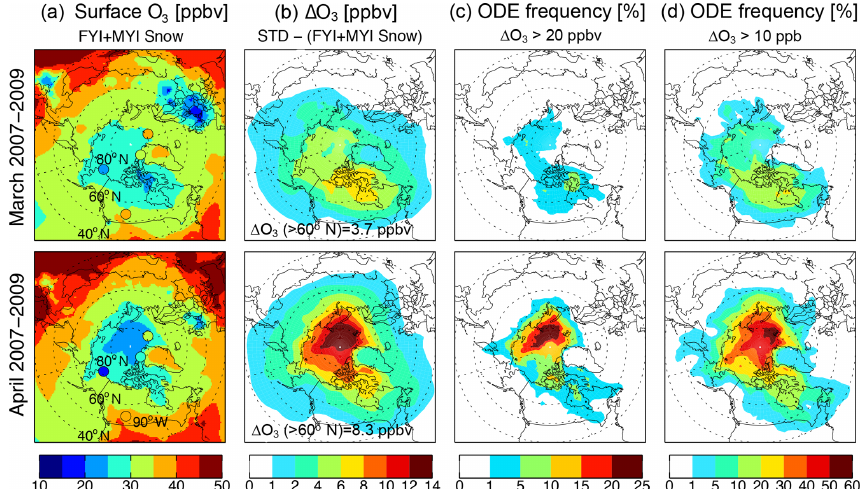
Figure 9. Monthly mean distribution of surface O 3 simulated with GEOS-Chem for March (top row) and April (bottom row) 2007–2009. (a) Surface O 3 mixing ratios in the GEOS-Chem FYI+MYI Snow simulation. The circles are color-coded by monthly mean surface O 3 observed at three Arctic (Utqia˙gvik, Alert, and Zeppelin) and one sub-Arctic site (Elk Island). (b) Decrease in surface O 3 ( (cid:49) O 3 , ppbv) due to blowing snow obtained as the difference between the STD and FYI+MYI Snow simulations. (c) Occurrence frequency of ODEs (in %), defined as the percent of time that more than 20ppbv of O 3 is lost due to blowing snow ( (cid:49) O 3 > 20ppbv). (d) Occurrence frequency of ODEs, defined as (cid:49) O 3 > 10ppbv.